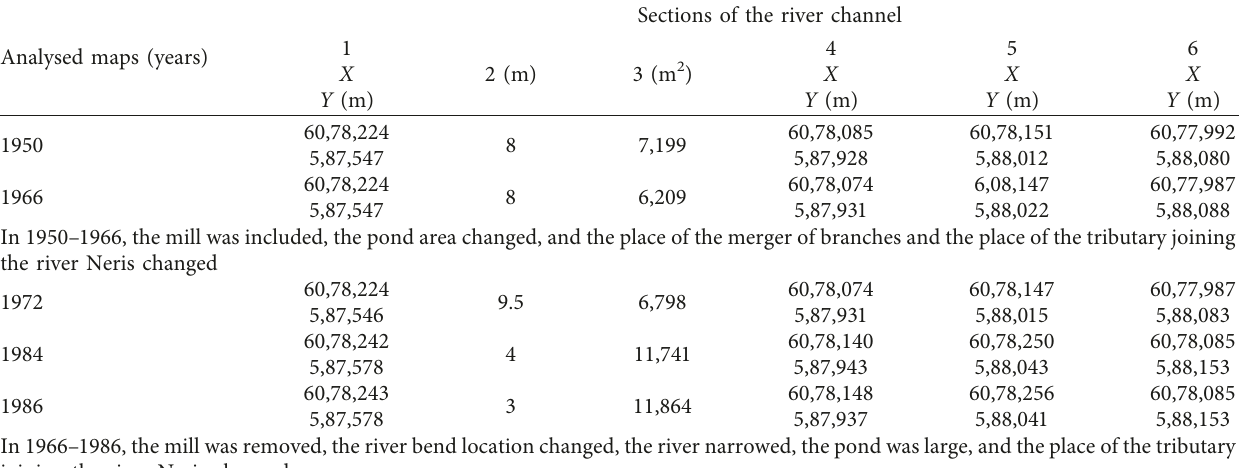
Table 1: Results of the river line